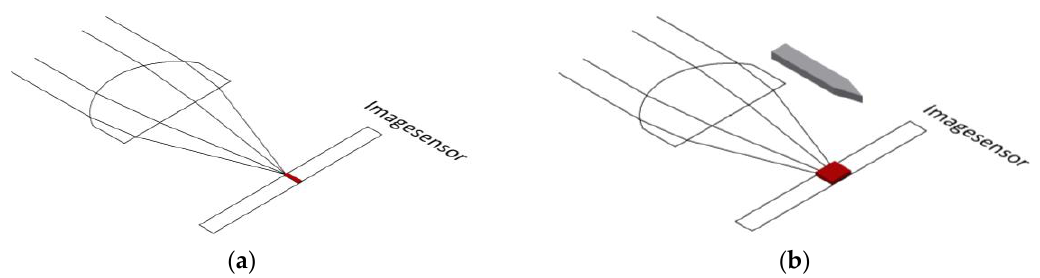
Figure 10. ( a ) Focusing without pressed z -axis; ( b ) Focusing with pressed z -axis.